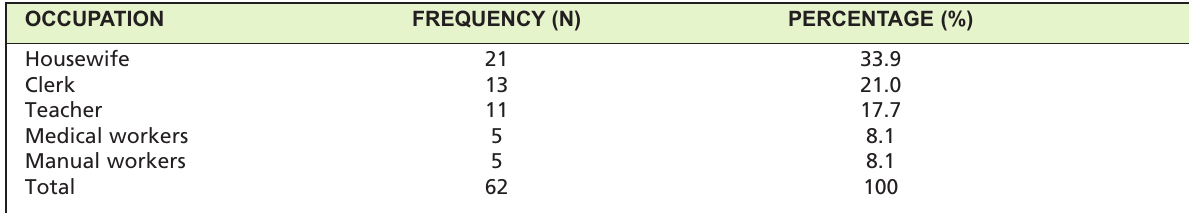
Occupations of CTS patients Table II: